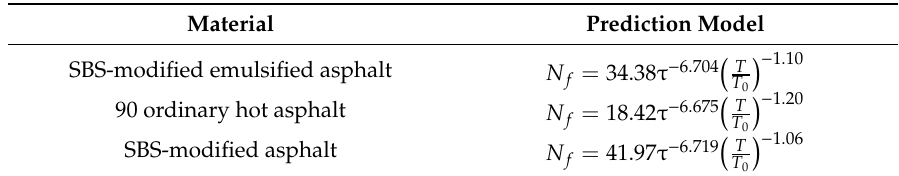
Shear fatigue life prediction model for waterproof cohesive layer materials with temperature